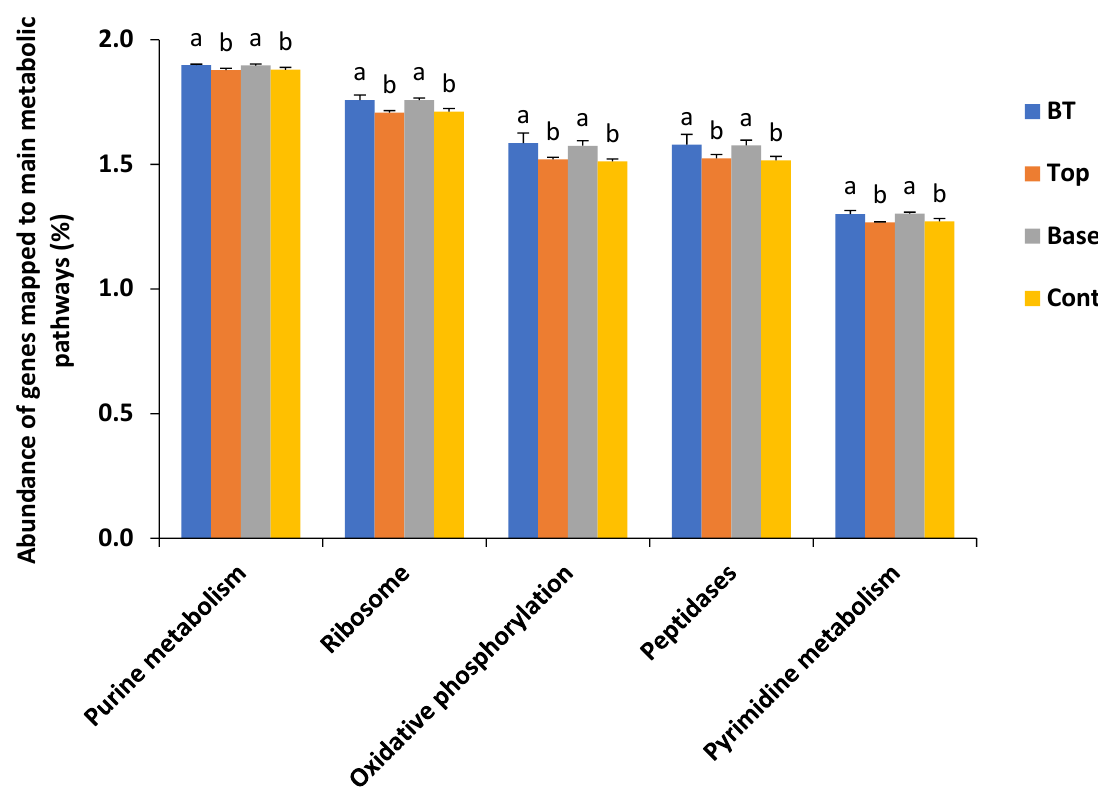
Figure 6. Abundance of genes mapped to main metabolic pathways among the three treatments and the control. BT, combined base fertilizer and topdressing fertilizer; Top, topdressing fertilizer; Base, base fertilizer; Control, no fertilizer. Different lowercase letters indicate significant differences at p < 0.05.